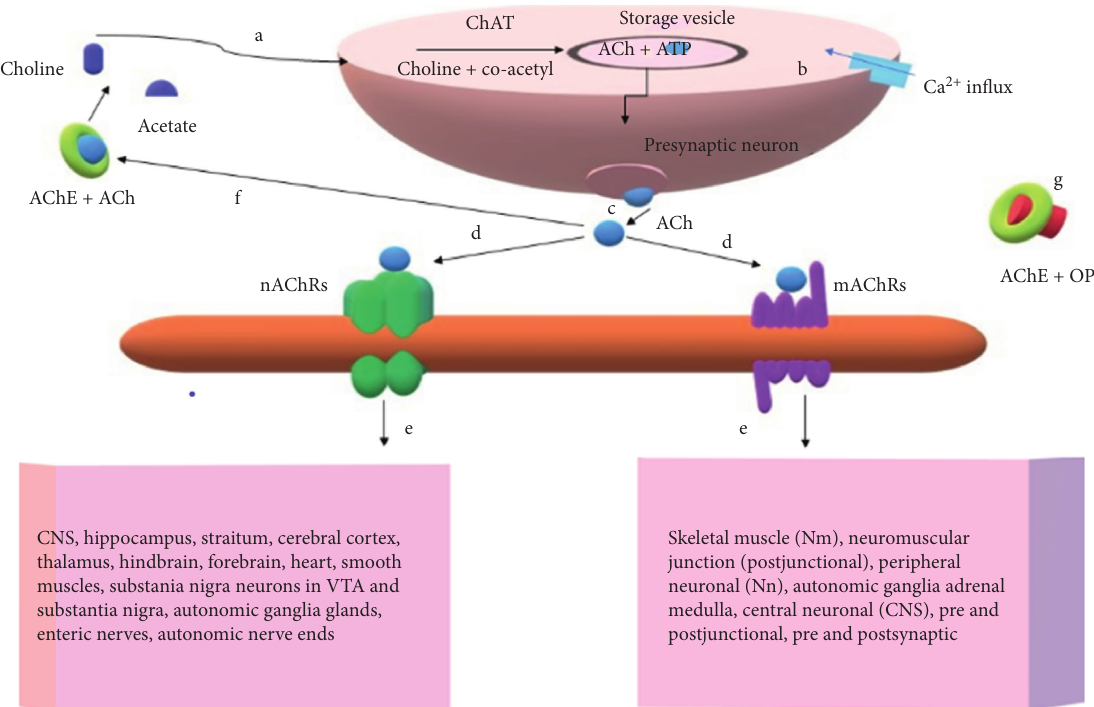
Figure 2: Depiction of cellular interaction of AChE, Ach, and OPCs. (a) Choline released from ACh hydrolysis, moves to axon where it reacts with acetyl moiety of co-acetyl to from ACh by an enzyme ChAT (choline acetyltransferase) and gets stored in vesicles along with cotransmitters such as ATP. (b) The influx of calcium results in the fusion of membranes. (c) Fusion leads to release of ACh into neuron junctions. (d) Interaction of ACh with nAChRs and mAChRs. (e) Signalling to different physiological targets. (f) Excess ACh after signalling, interacts with AChE and degrades into choline and acetate. (g) OPC binds with AChE and leads to increased ACh and endless